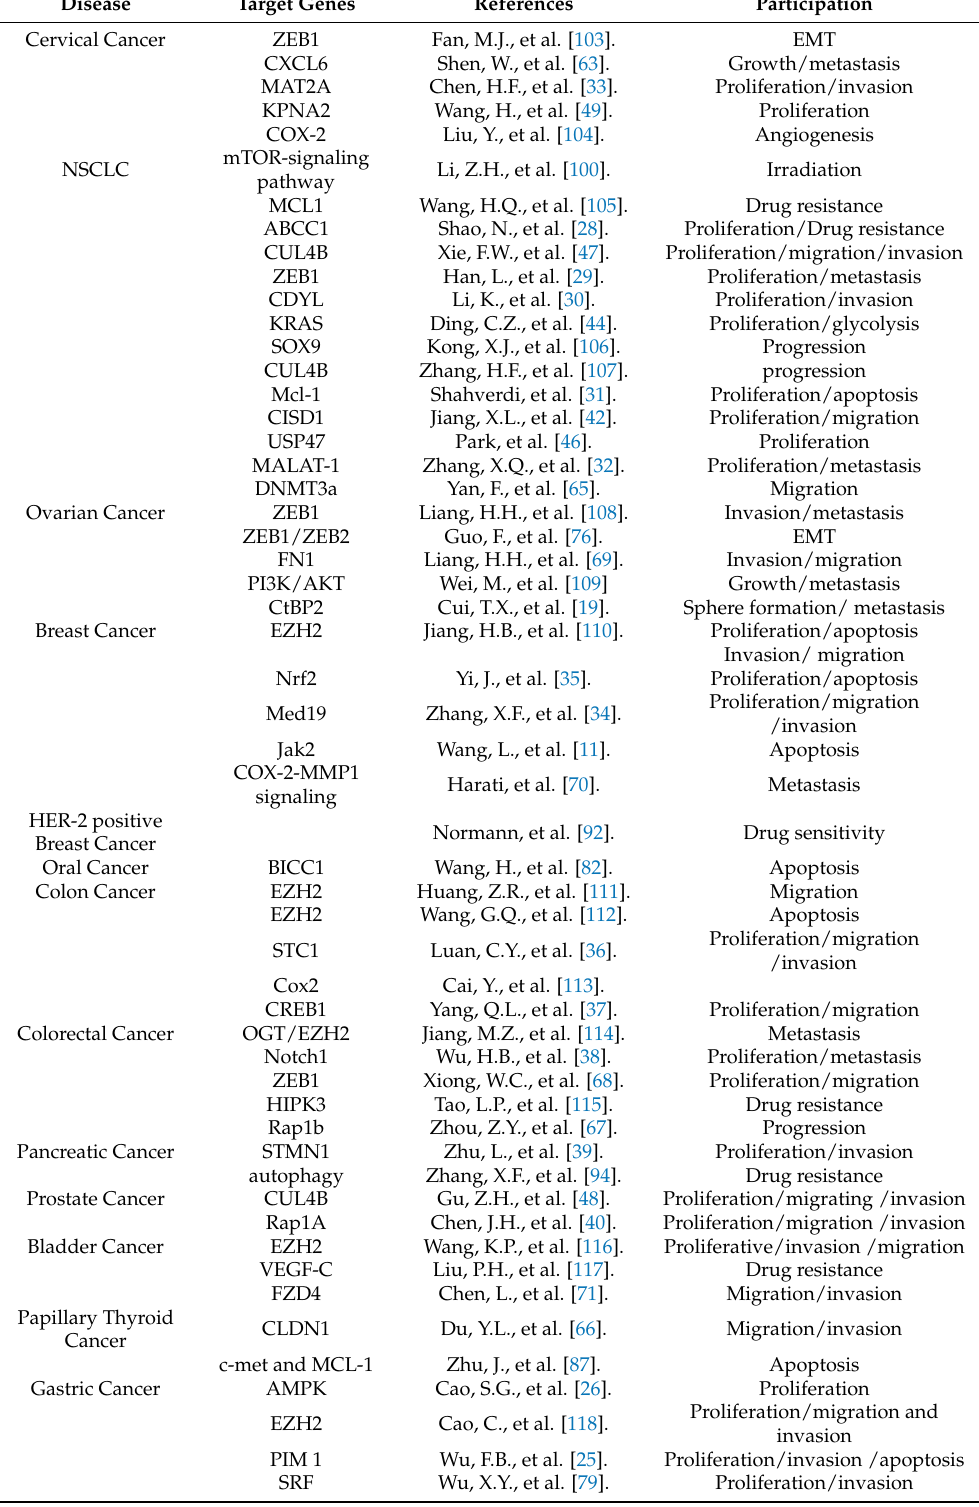
Table 1. New target genes and dysregulation of miR-101 in proliferation, apoptosis, angiogenesis, drug